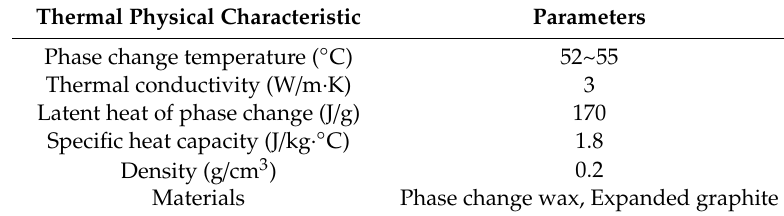
Figure 1. Experimental conditions Table 2. Thermal physical properties of PCM.